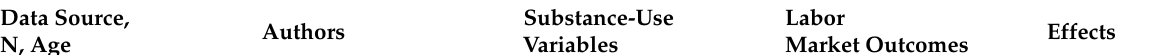
Table 2. Effects of Substance-Use Disorders on